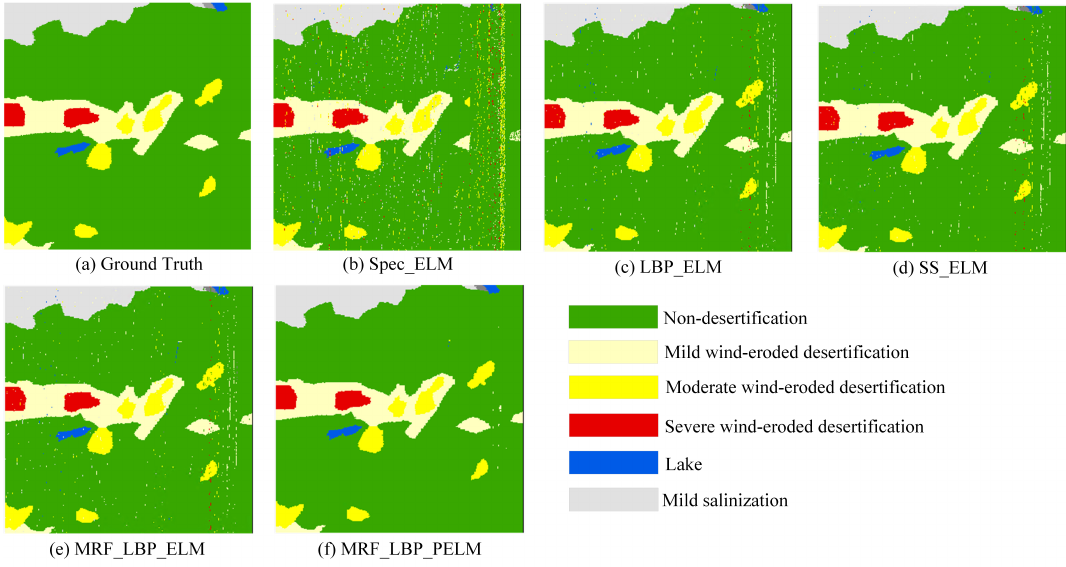
Figure 13. Comparison of visual interpretation results of different methods on ecological restoration demonstration areas